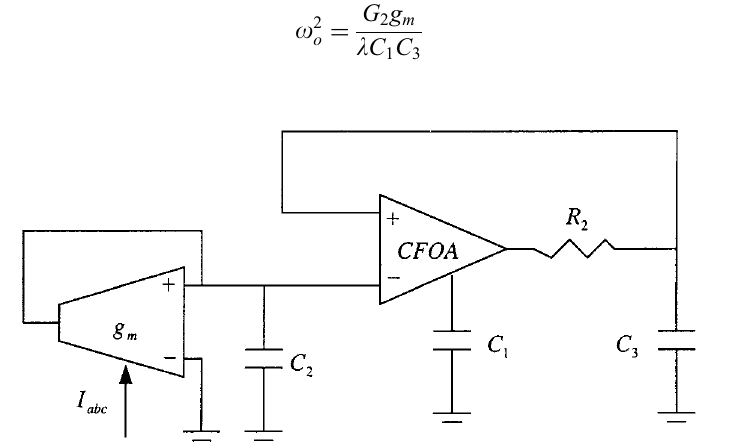
FIGURE 2 Proposed sinusoidal oscillator